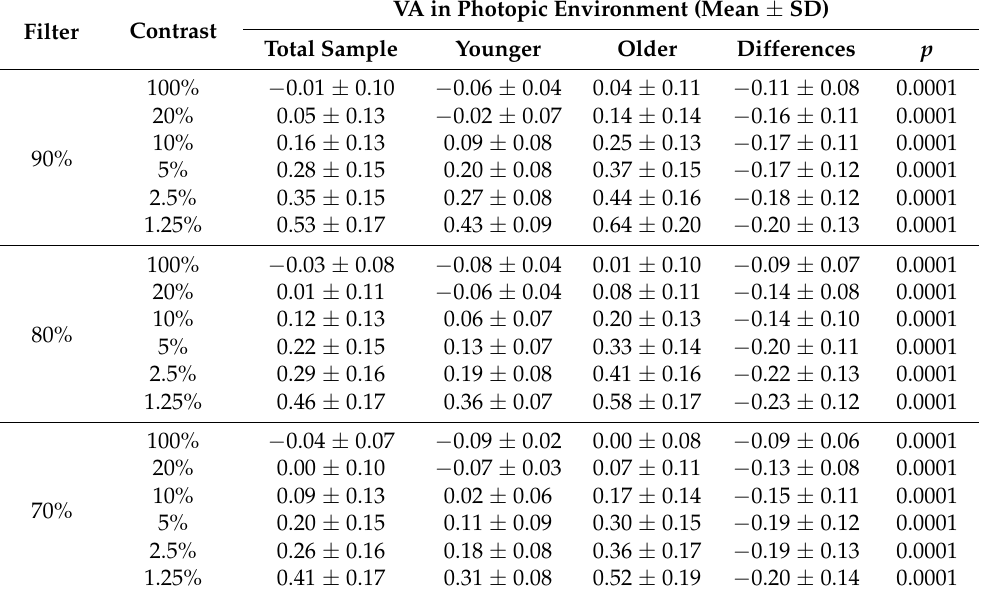
Table 3. Visual Acuity of the total sample and by age group with the different filters and contrast.